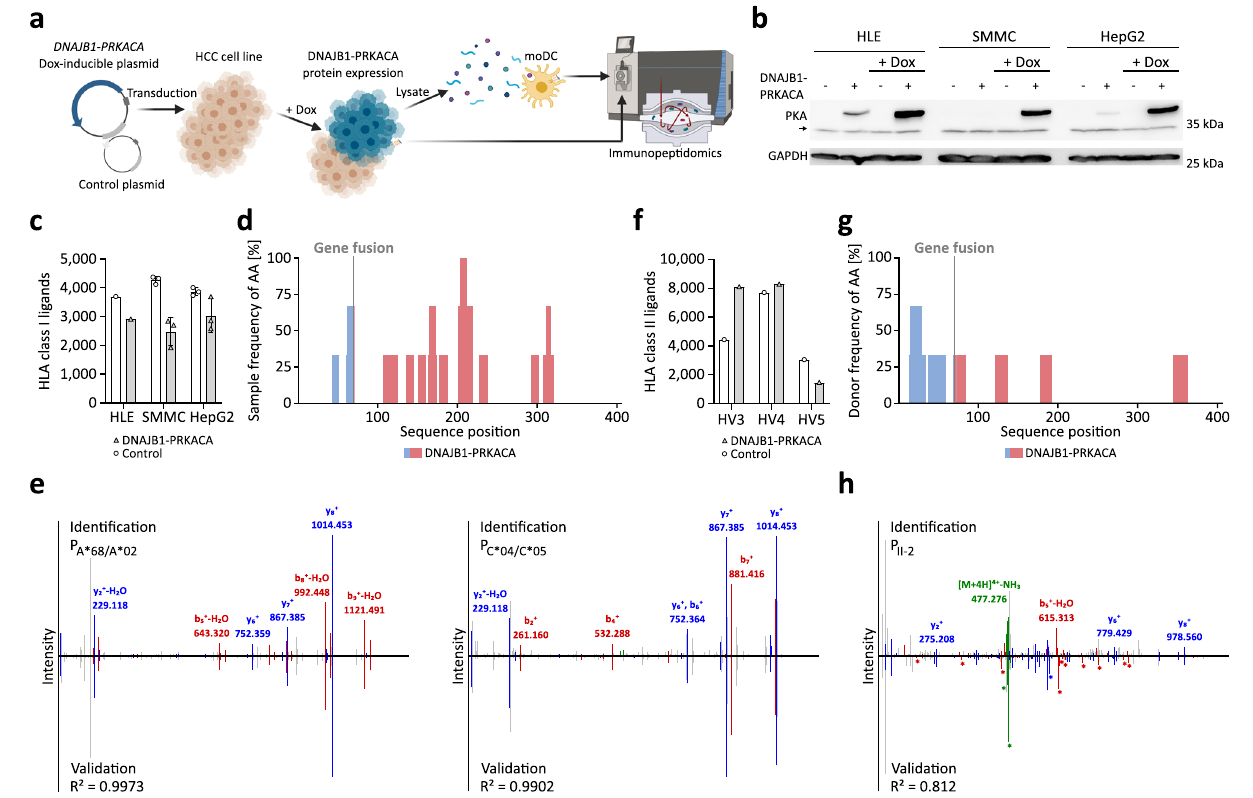
Fig.3|Massspectrometry-basedidenti fi cationofnaturallypresentedDNAJB1- PRKACA-derived HLA class I and HLA class II ligands. a Schematic overview of Doxycycline (Dox)-inducible DNAJB1-PRKACA fusion gene expression. Hepatocel- lularcarcinoma(HCC)celllinestransducedwithDNAJB1-PRKACADox-inducibleor controlplasmid weretreatedwith Dox followed by mass spectrometry (MS)-based immunopeptidome analysis of the HCC cell line, or of mature monocyte-derived dendritic cells (moDC) of a healthy volunteer (HV) incubated with HCC cell line lysate (created with BioRender.com). b Dox-induced DNAJB1-PRKACA expression by immunoblotting of HCC cell lines (HLE, SMMC-7721, and HepG2) carrying the DNAJB1-PRKACADox-inducible(+)orthecontrolplasmid( − )withandwithoutDox treatment using an anti-Protein Kinase A (PKA) antibody ( n =3). The black arrow indicates the endogenous PKA band. GAPDH served as a loading control. c , f MS- identi fi edpeptidesof c HCCcelllines(HLE n =1,SMMC-7721 n =3,andHepG2 n =3) carrying the DNAJB1-PRKACA Dox-inducible or the control plasmid after Dox- treatment (data arepresented asmean values±SD) and f of maturemoDCs of HVs incubated with HCC cell line lysate with or without expression of DNAJB1-PRKACA protein, respectively. d , g Distribution of MS-identi fi ed HLA ligands over the